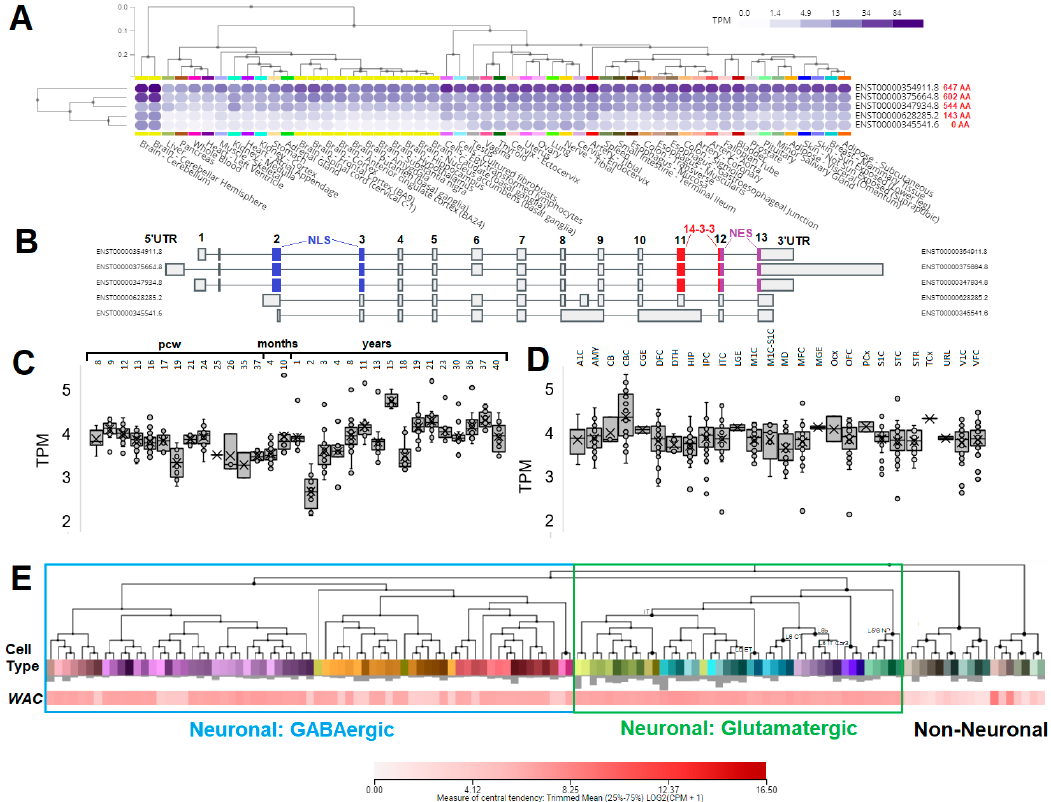
Figure 4. Analysis of WAC expression in various tissues, the brain developmental times, and within single-cell types of human brain. ( A ) GTEx expression of WAC isoforms in various human tissues. The darker blue color represents higher expression. Tissues are ranked in expression. In red next to each isoform number is the amino acid size of the protein. ( B ) Annotated exons of each isoform as shown in panel A. In blue are exons that code for the NLS, red the 14-3-3 interaction site, and magenta the NES. ( C , D ) The developmental transcriptome data of BrainSpan shown as box and whisker plots of age ( C ) or tissue type ( D ). Abbreviations include: pcw- post-coital weeks, A1C— primary auditory cortex (core), AMY—amygdaloid complex, CB—cerebellum, CBC—cerebellar cortex, CGE—caudal ganglionic eminence, DFC—dorsolateral prefrontal cortex, DTH—dorsal thal- amus, HIP—hippocampus (hippocampal formation), IPC—posteroventral (inferior) parietal cortex, ITC—inferolateral temporal cortex (area TEv, area 20), LGE—lateral ganglionic eminence, M1C— primary motor cortex (area M1, area 4), M1C-S1C—primary motor-sensory cortex (samples), MD— mediodorsal nucleus of thalamus, MFC—anterior (rostral) cingulate (medial prefrontal) cortex, MGE—medial ganglionic eminence, Ocx—occipital neocortex, OFC—orbital frontal cortex, PCx— parietal neocortex, S1C—primary somatosensory cortex (area S1, areas 3,1,2), STC—posterior (cau- dal) superior temporal cortex (area 22c), STR—striatum, TCx—temporal neocortex, URL—upper (rostral) rhombic lip, V1C—primary visual cortex (striate cortex, area V1/17), VFC—ventrolateral prefrontal cortex, TPM—transcripts per million. ( E ) Single-cell expression from the Allen Brain Atlas Human MTG-10X (SEA-AD) data. Deeper red represents higher expression of WAC. Clustering shows grouped cells within labeled neuronal groups.